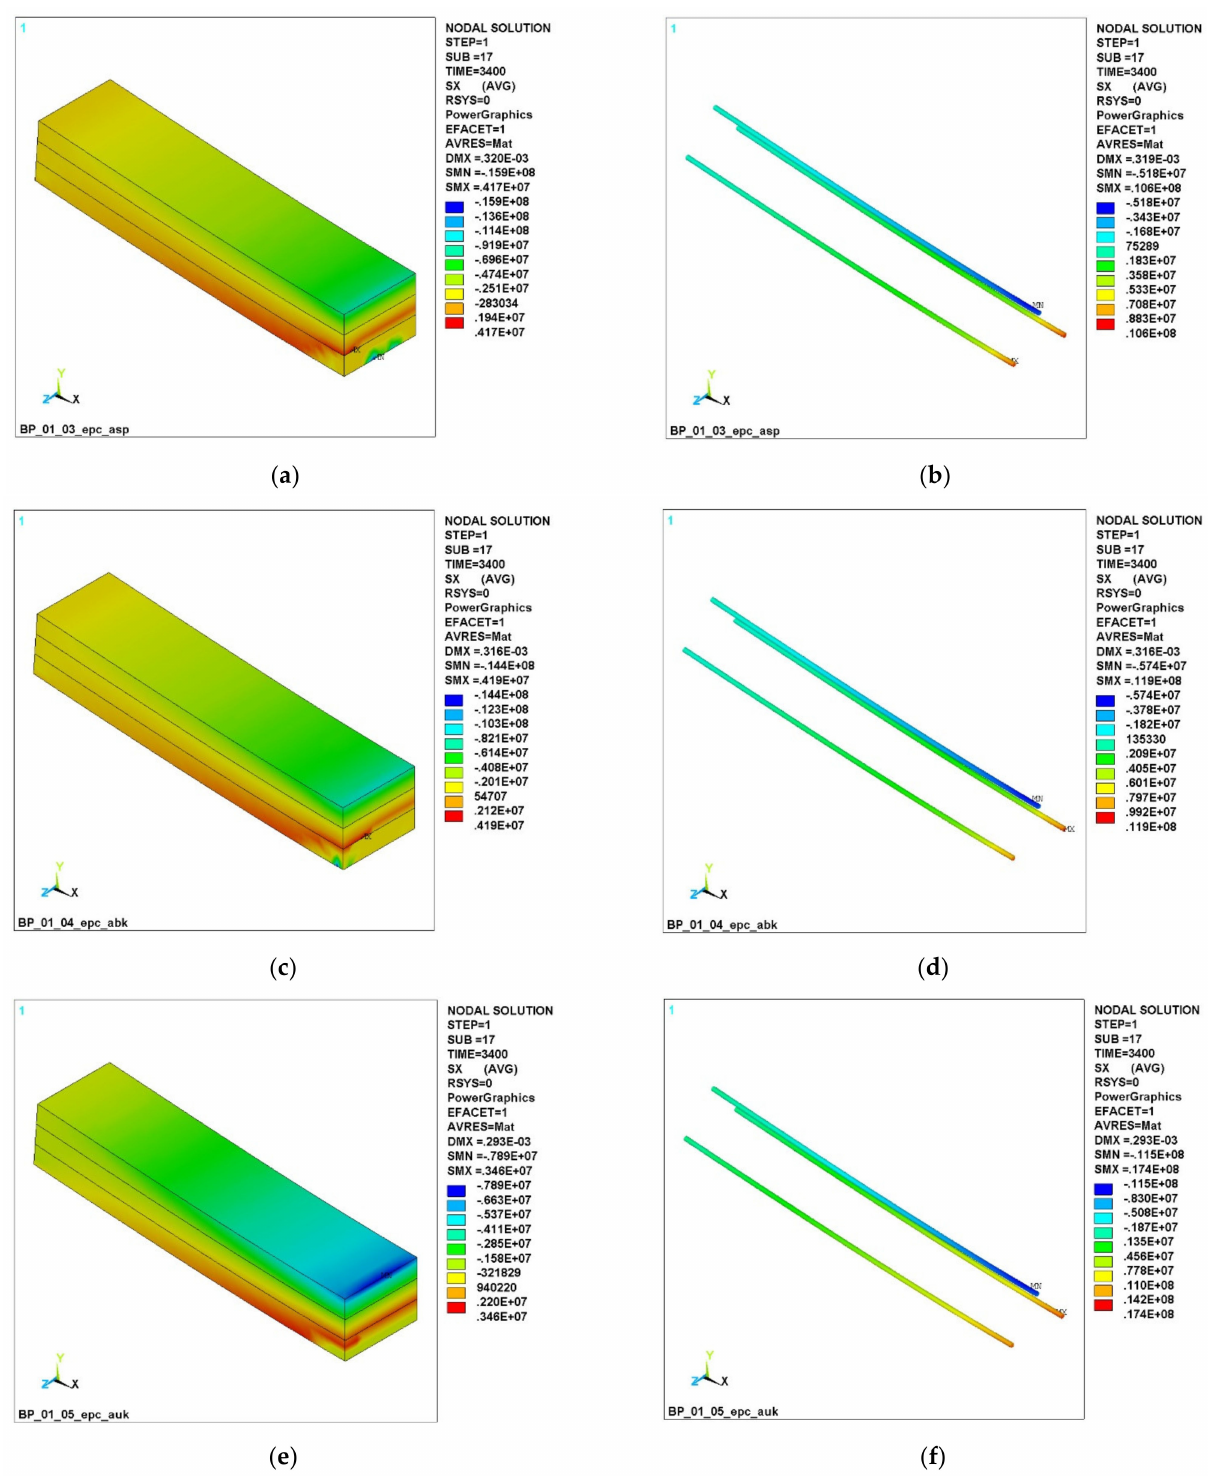
Figure 6. Normal stress σ X fields at a load of 3400 N: ( a ) in concrete with GCR; ( b ) in GCR; ( c ) in concrete with BCR; ( d ) in BCR; ( e ) in concrete with CCR; ( f ) in